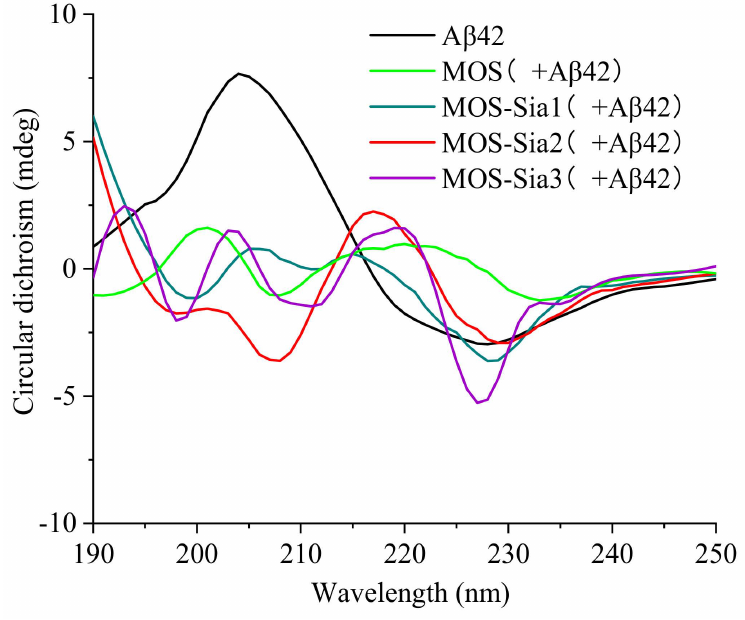
Figure 4. CD analysis of the interaction between MOS-Sia and A β